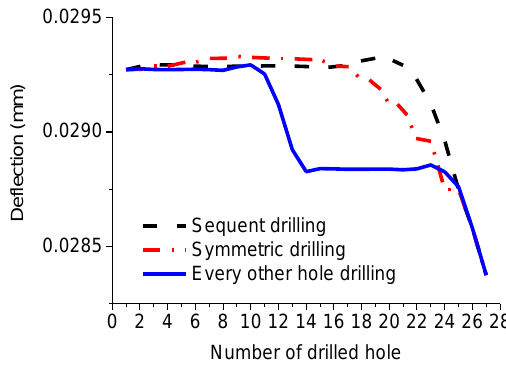
Figure 20. Variation in strain energy with amount of drilling.